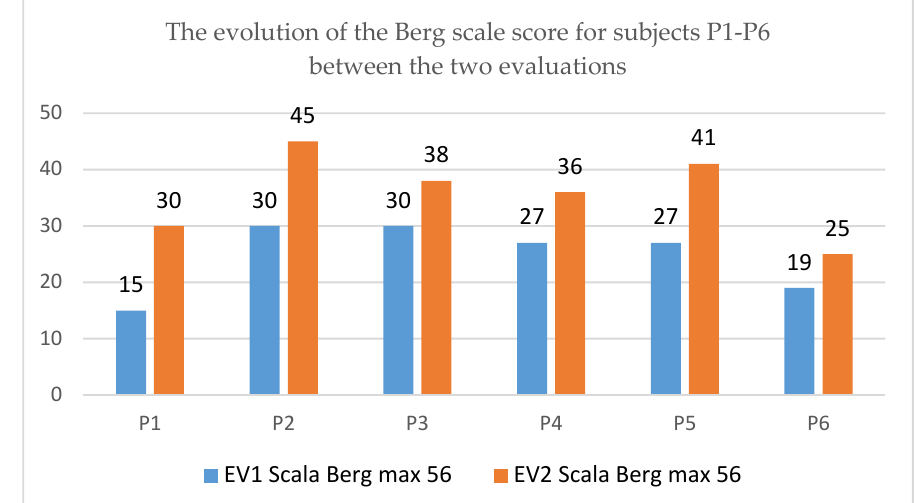
Figure 8. The evolution of the Berg scale score for subjects P1–P6.